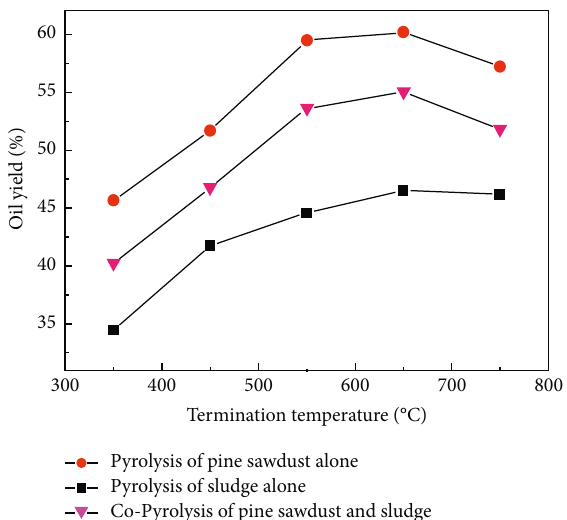
Figure 3: Influence of pyrolysis termination temperature on fixed- bed pyrolysis process.